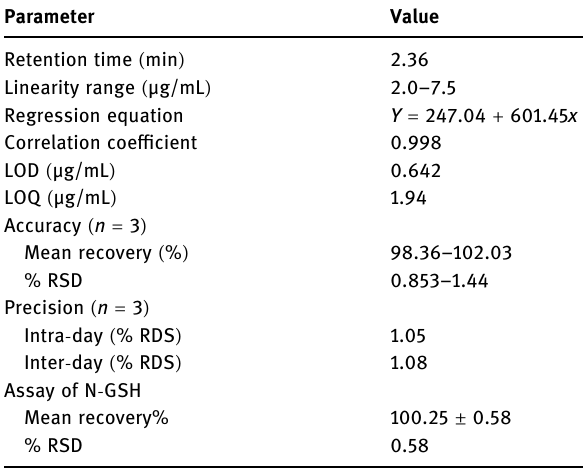
Table 4: Vesicle size, zeta potential, PDI, and EE% for the selected formulation GTN8 stored at 4°C and at room temperature for four